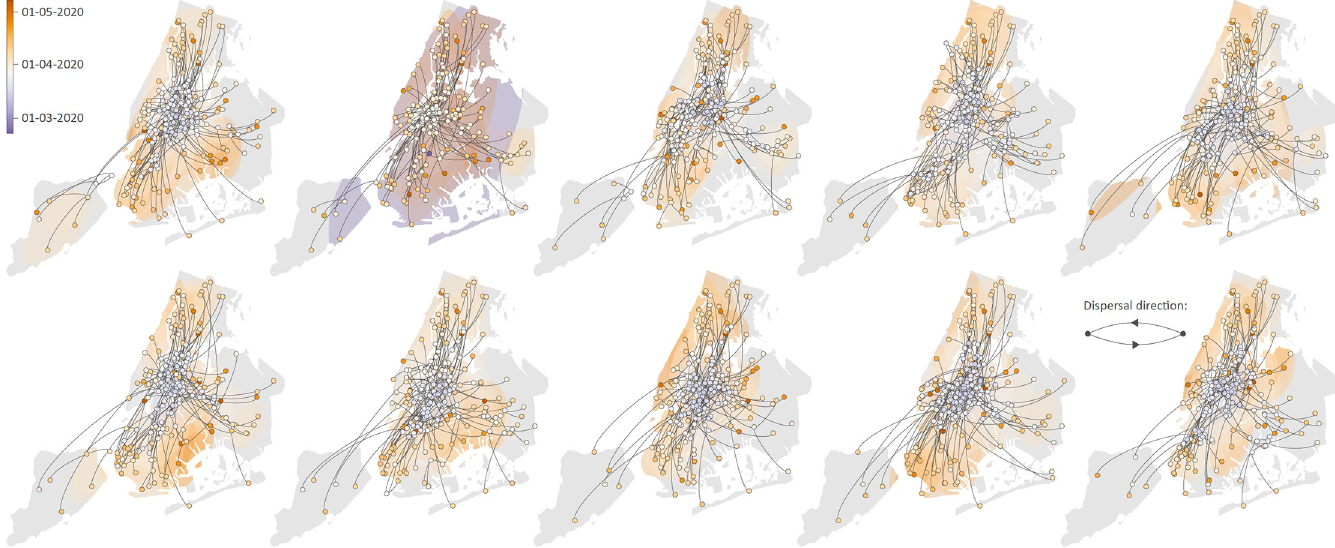
Fig 2. Continuous phylogeographic analyses of the main SARS-CoV-2 clade circulating in New York City (NYC) during the first epidemic wave. Each map corresponds to a distinct replicated phylogeographic inference based on a random subset of genomic sequences obtained after having subsampled NYC boroughs according to their cumulative number of new hospitalizations until the most recent sample (see the Methods section for details). For each replicated analysis, we mapped the maximum clade credibility (MCC) tree and overall 80% highest posterior density (HPD) regions reflecting the uncertainty related to the Bayesian phylogeographic inference. MCC trees and 80% HPD regions are based on 1,000 trees sampled from each post burn-in posterior distribution. Dispersal direction (anti-clockwise) of viral lineages is indicated by the edge curvature, MCC tree nodes are colored according to their time of occurrence, and 80% HPD regions were computed for successive time layers and then superimposed using the same color scale reflecting time. See also S2 Fig for an alternative visualization summarizing lineage dispersal events among and within NYC boroughs, and S3 Fig for the alternative yet consistent continuous phylogeographic reconstructions based on a diffusion model allowing the assessment and inference of a directional trend. Base layer for the maps has been obtained from https://www.census.gov.